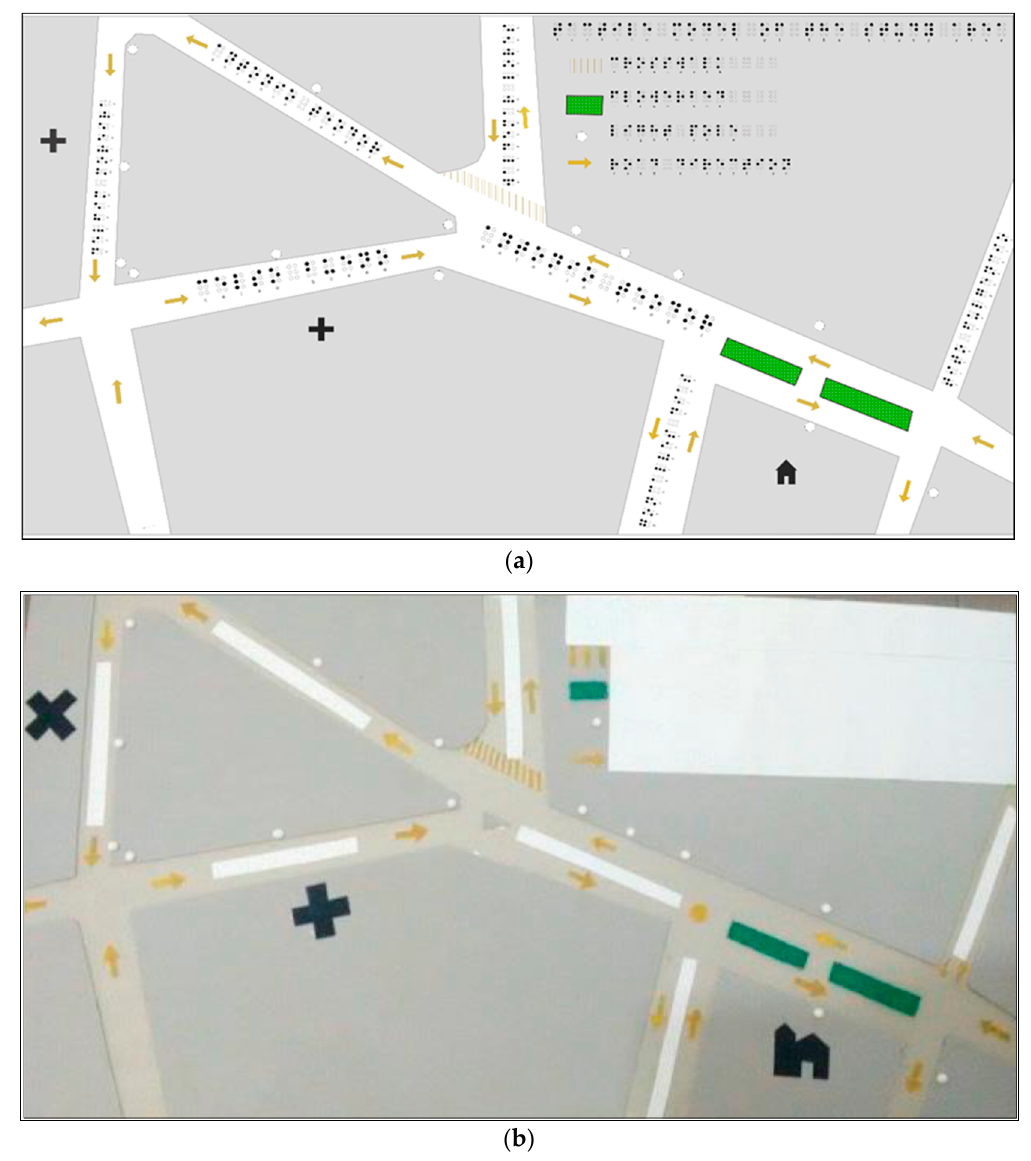
Figure 4. ( a ) Tactile model project; ( b ) tactile model implemented.